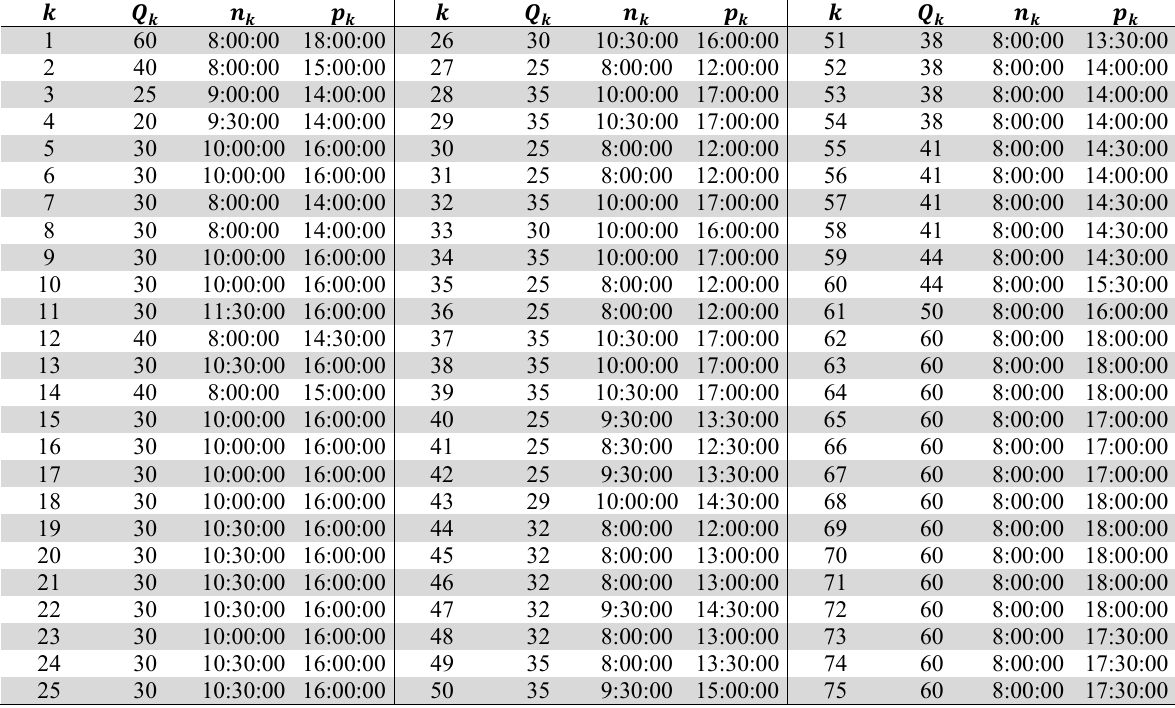
Capacity and time window of vehicles in case